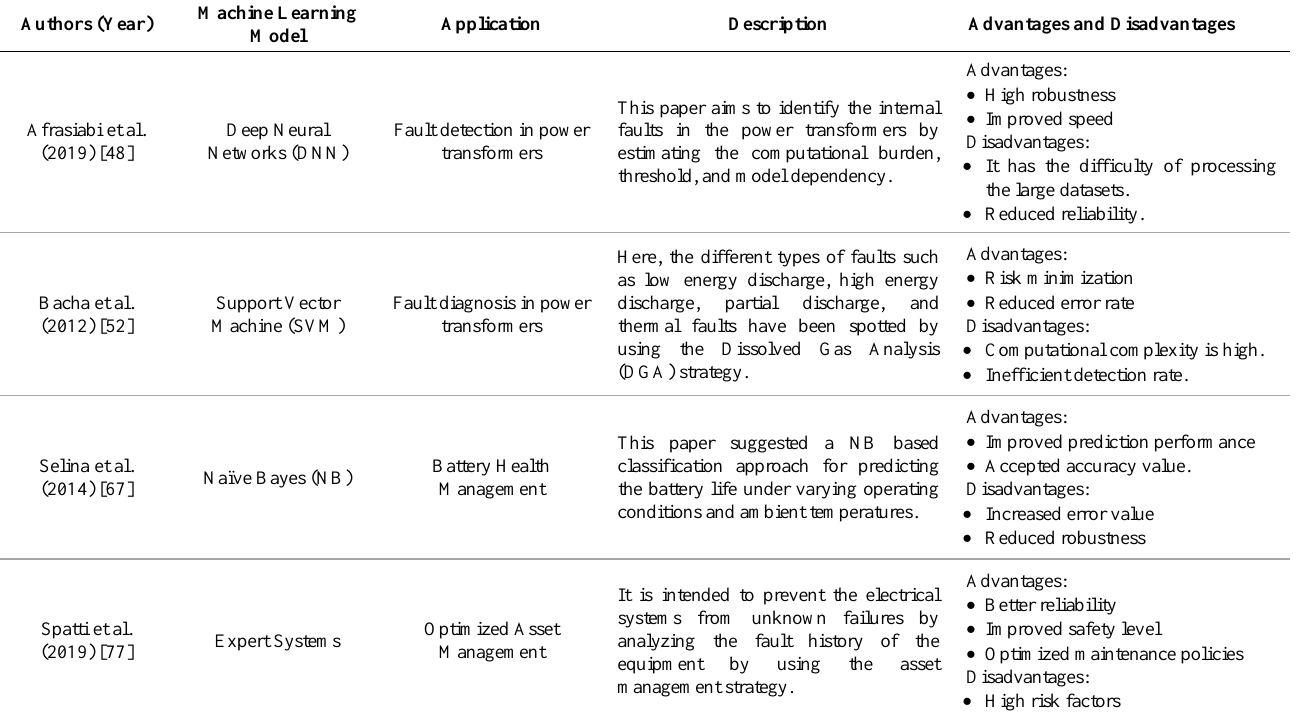
Table 1. Comparative analysis between various machine learning